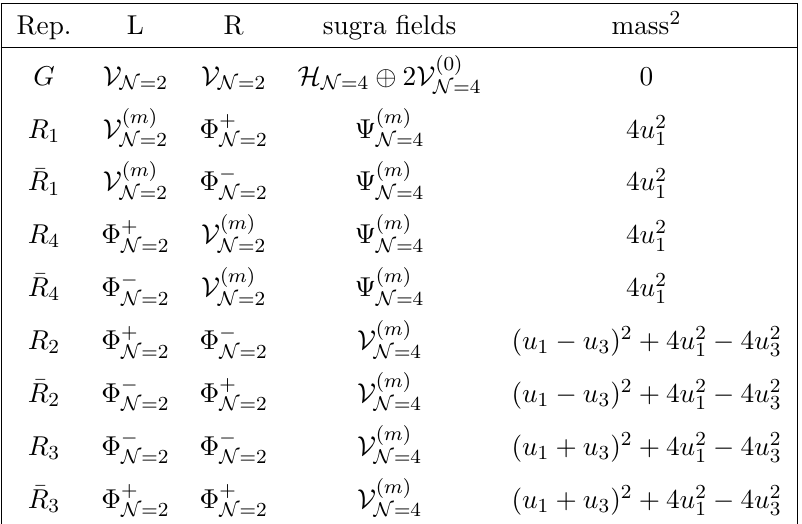
Table 5 . Spectrum of the explicitly-broken theory with N = 4 residual supersymmetry and U(1) 2 unbroken gauge